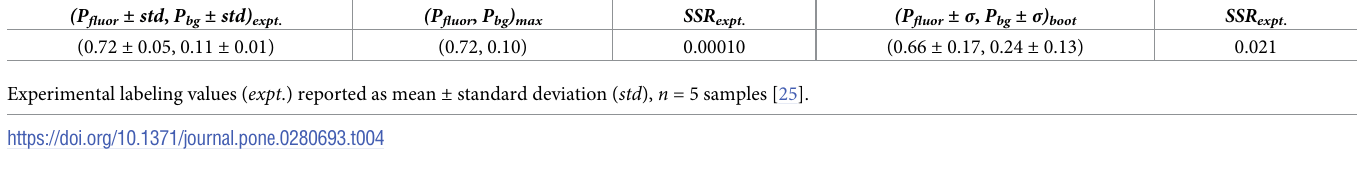
Table 4. Global fitting over all RCLC samples 1–5, and χ rec . = 2 x 10 − 9 to 2 x 10 − 6 . (P fluor ± std , P bg ± std) expt